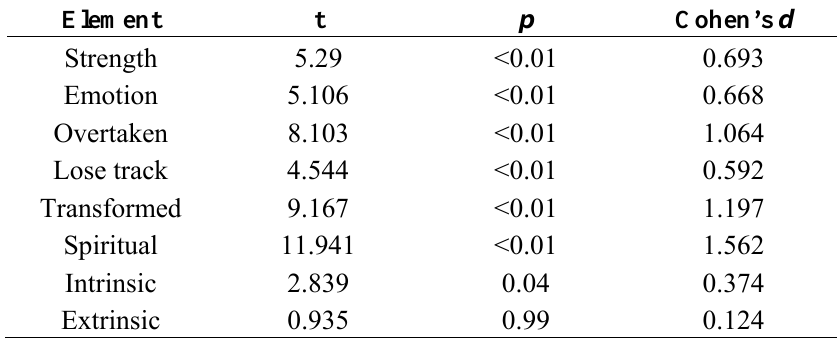
Table 4 ． T-test results and effect size (Cohen’s d) for comparison between Religious and non-Religious